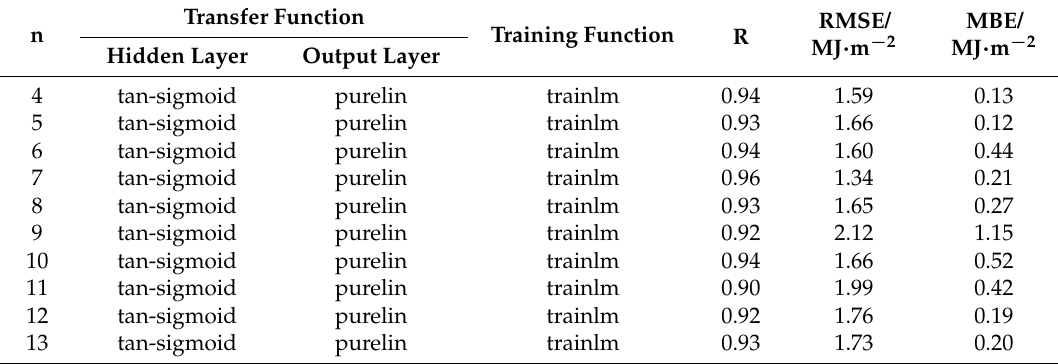
Table 1. Training results for different configurations in the hidden